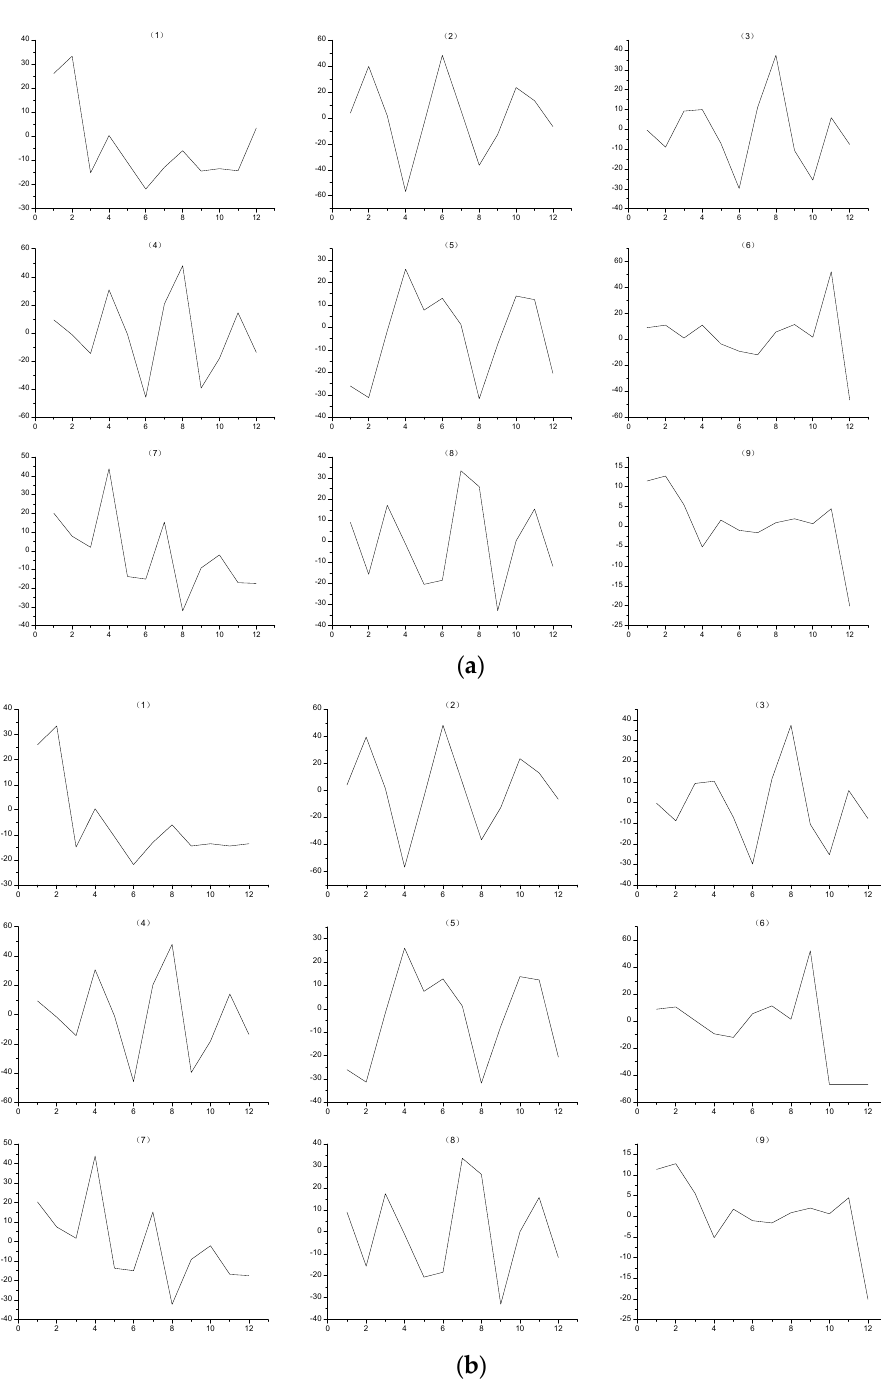
Figure 11. The part wavelet packet coefficient group before and after predicted. ( a ) Original part wavelet packet coefficient group; ( b ) Part wavelet packet coefficient group of peak-type Markov chain prediction.